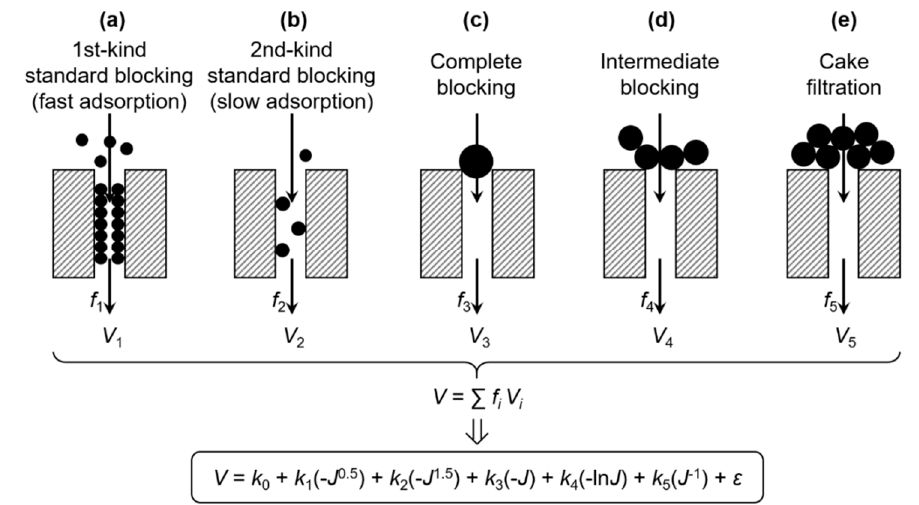
Figure 1. Scheme of the multiple linear regression model for membrane fouling.